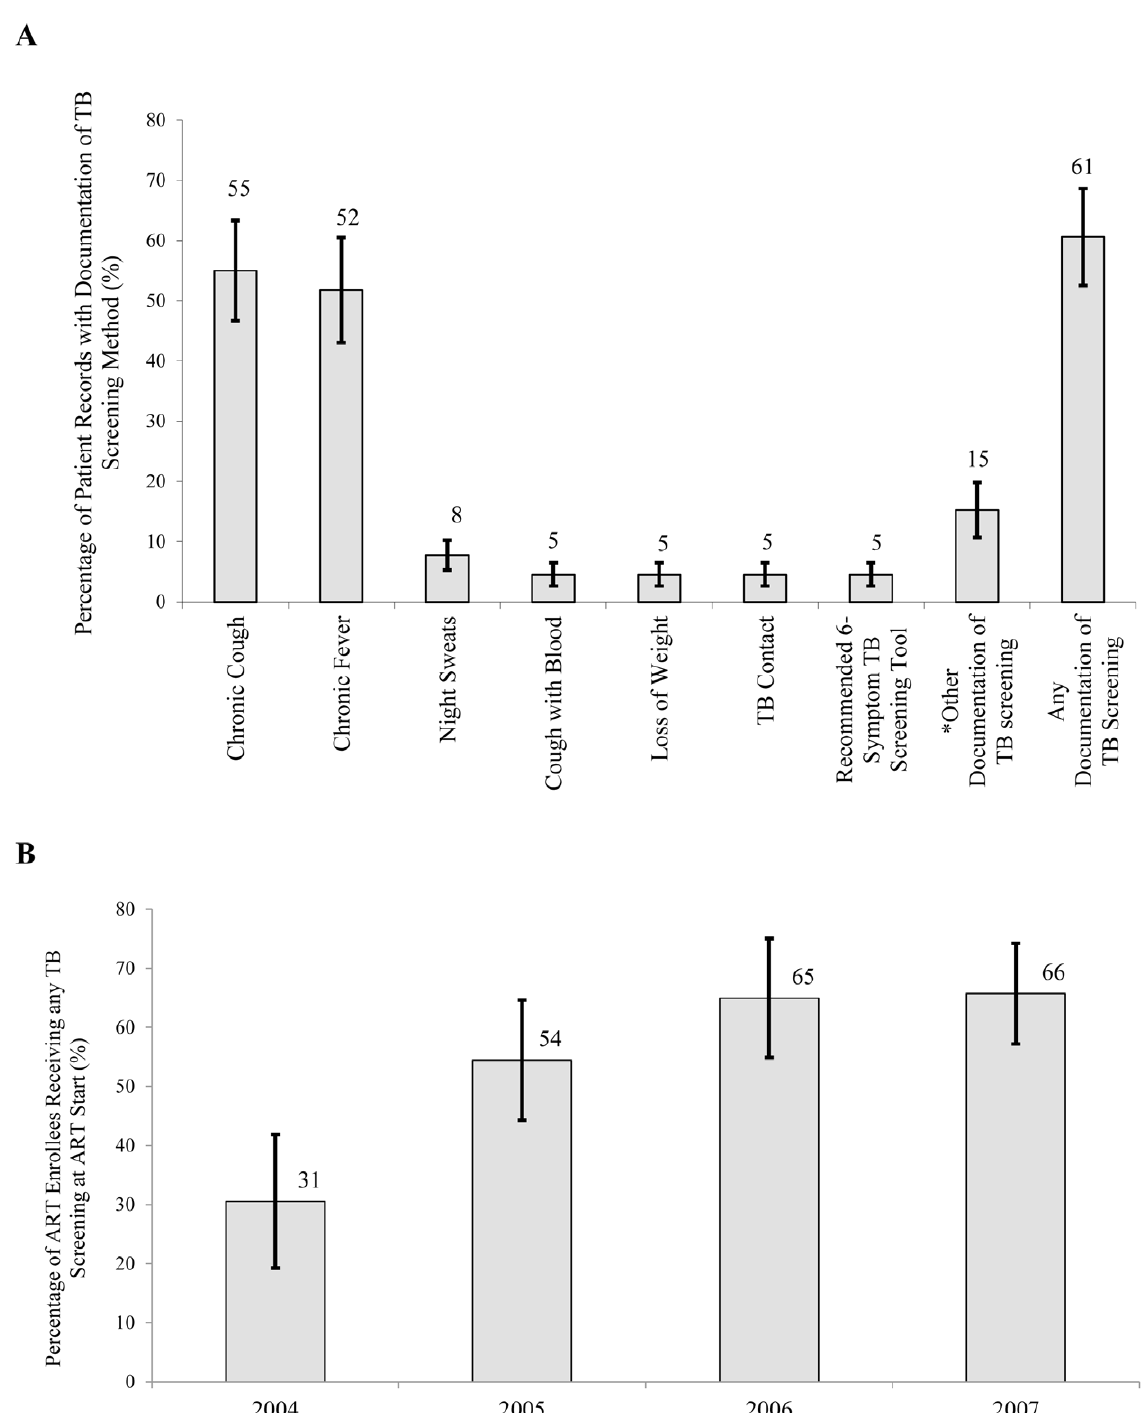
Figure 1. Compliance with TB Screening among ART Enrollees. A TB Screening among Patients at ART Enrollment in Mozambique during 2004–2007 (n=2,596) . * ‘‘Other’’ includes patients taking TB treatment at ART initiation, or for whom ‘‘No TB’’ or ‘‘TB screen negative’’ was written in the medical record. B Improvement in Proportions of ART Enrollees Screened for TB in Mozambique during 2004–2007 (n=2,596).